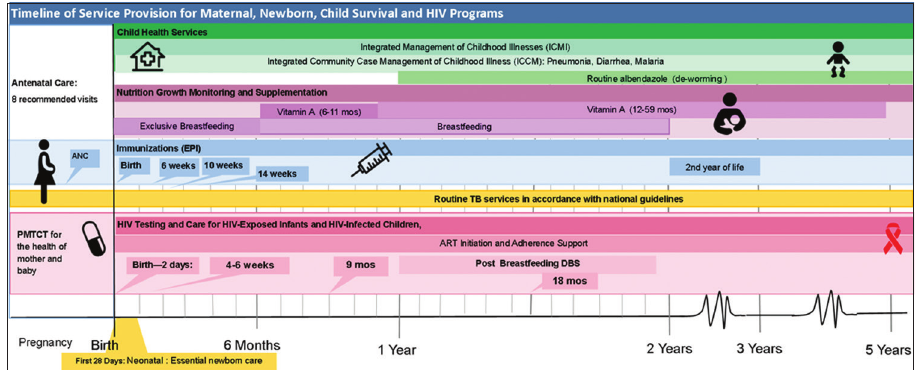
Figure1: Timeline of Service Provision for Maternal, Newborn, Child Survival and HIV Programs. Notes: In sub-Saharan Africa, prog - ress on reducing preventable child deaths and increasing antiretroviral therapy (ART) coverage in children living with HIV (CLHIV), while gaining ground, has been slower than desired. Too often, the delivery of health programs for children are “siloed” in specific intervention areas focused on HIV, TB, Nutrition, or Immunizations. This is often a product of how Ministries of Health or clinics are organized, or how international donor funding streams are allocated and regulated. “Siloed” or non-integrated programs can lead to mother-child dyad being reached with one type of intervention, while being missed for another. Programmers and implementers could better optimize each clinical “touch-point” with a mother-child dyad to provide more integrated and comprehensive services. Abbreviations and acronyms: ART-Antiretroviral Therapy, DBS-Dried Blood Spot, EPI-Expanded Program on Immunization, HIV- Hu - man Immunodeficiency Virus, PMTCT-Prevention of Mother to Child Transmission,